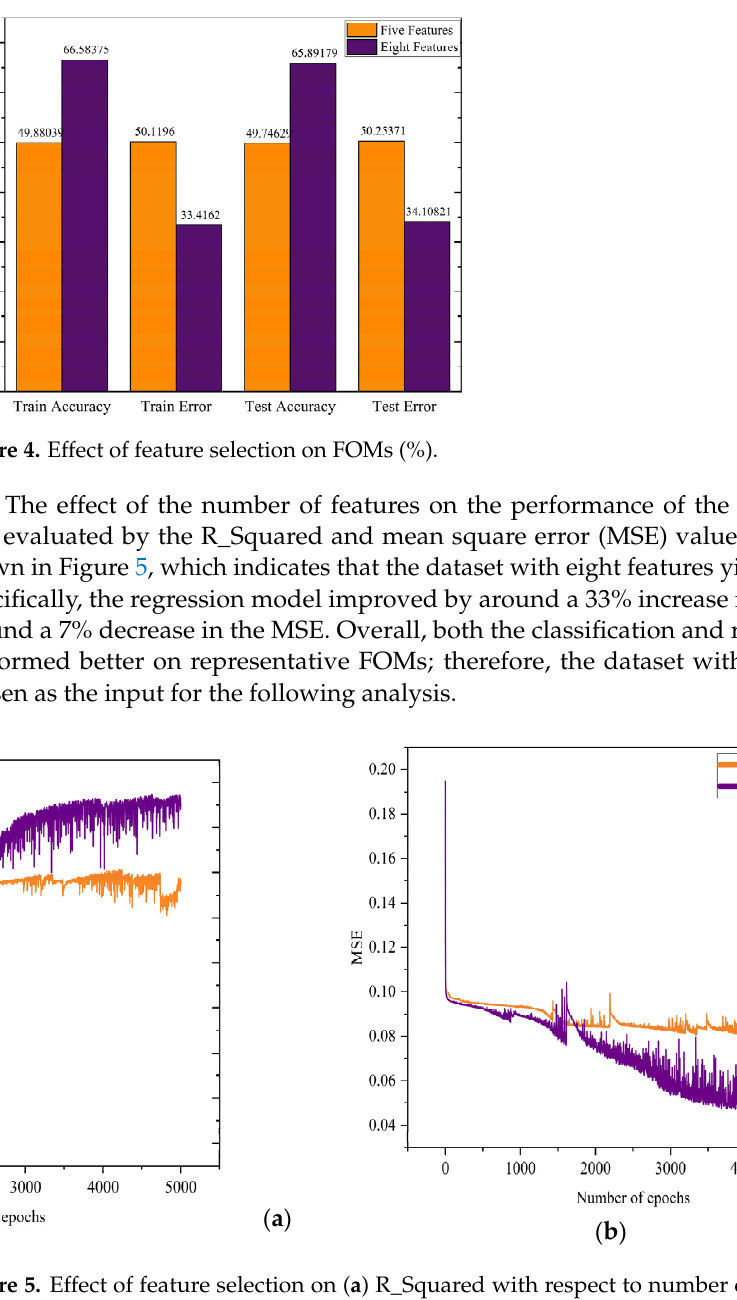
Figure 5. Effect of feature selection on ( a ) R_Squared with respect to number of epochs; ( b ) mean square error (MSE) with respect to number of epochs.